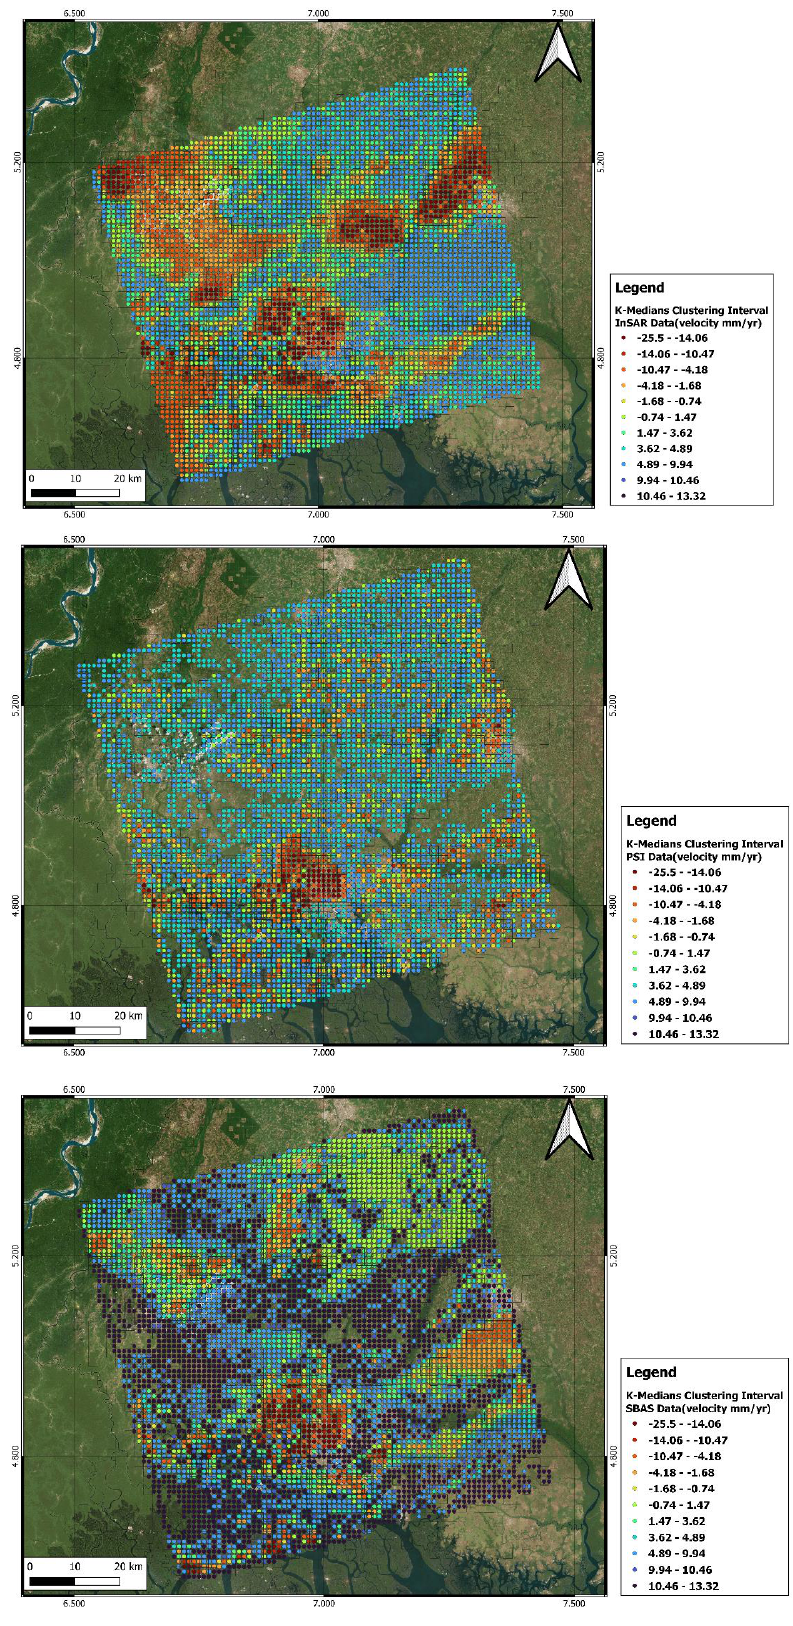
Figure 13. Obtained mean displacement rate maps from different interferometric techniques, including ( up ) InSAR, ( mid ) PSI, and ( down ) SBAS, by applying the K-medians clustering algorithm.